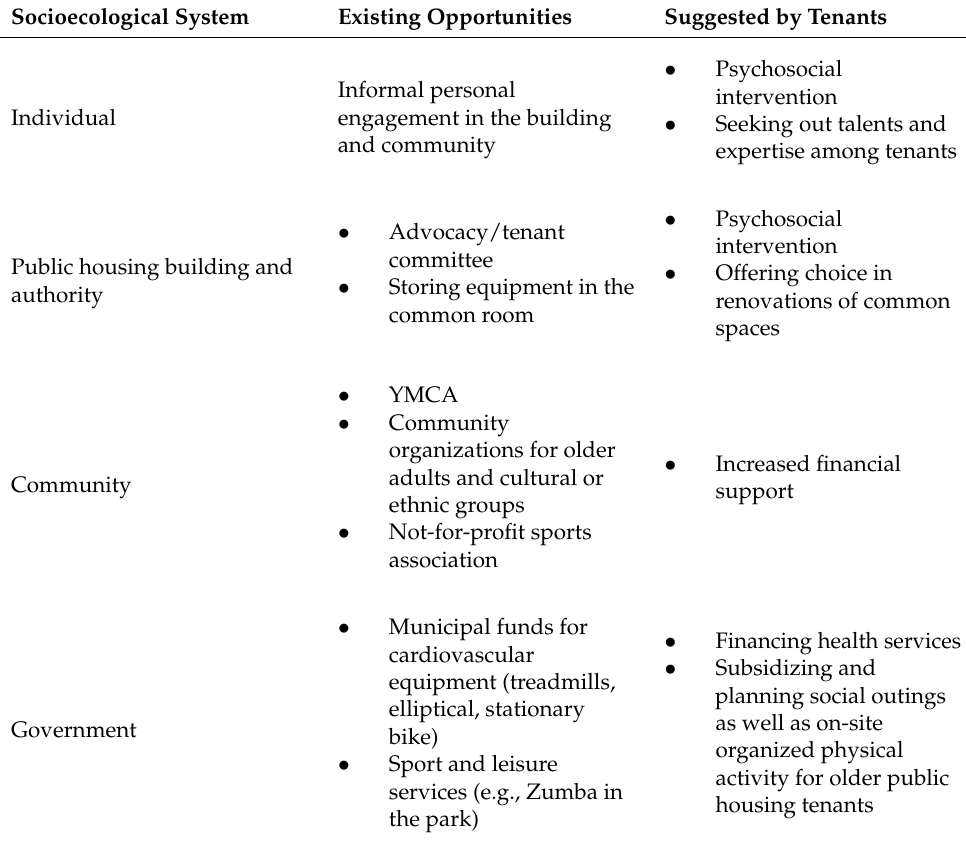
Table 3. Occasions for capability and capacity building per level of the ecological